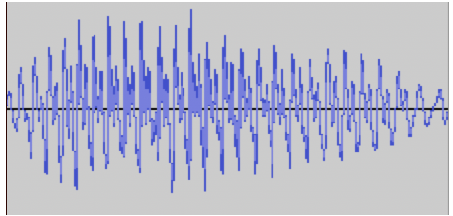
Figure 2. Waveform of spoken digit nine.